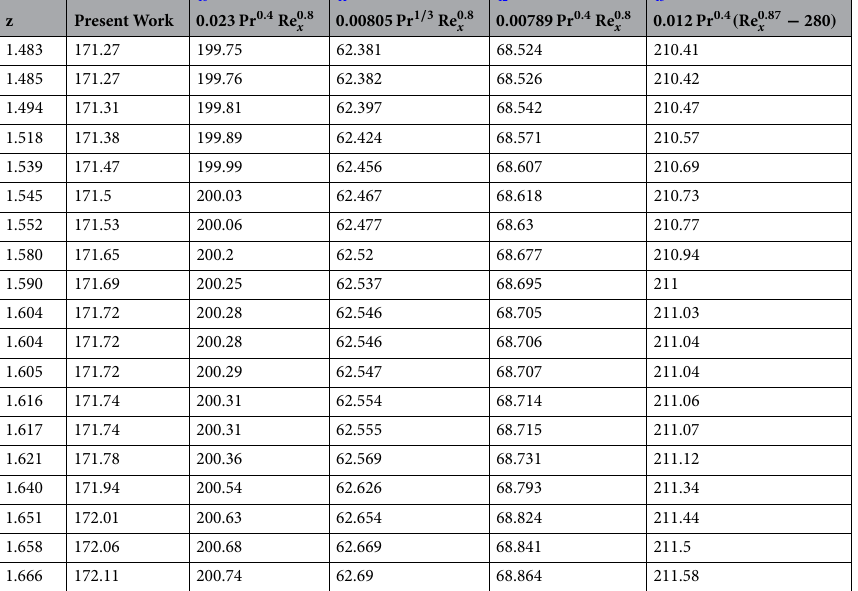
Table 2. Comparison table of the Nusselt